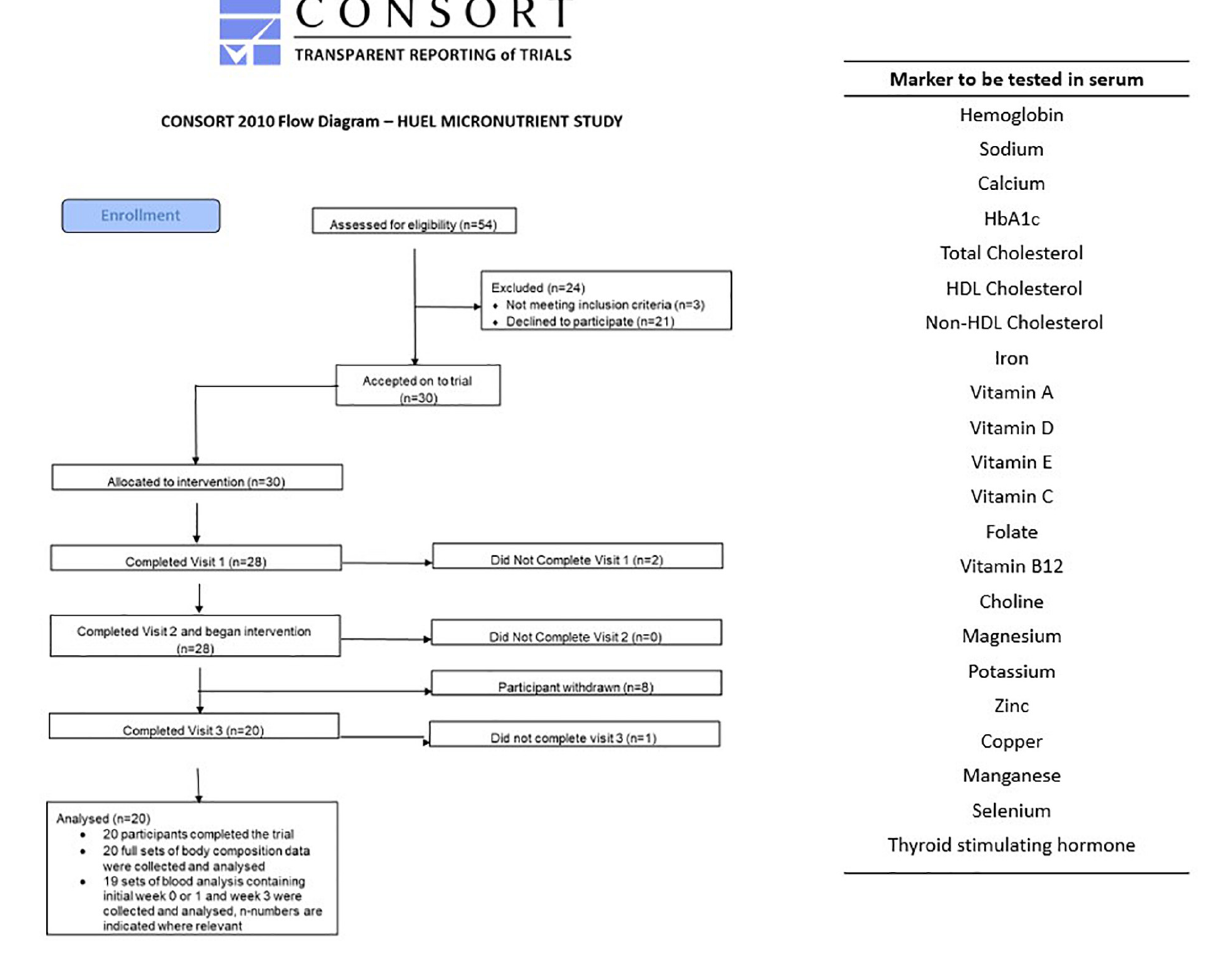
FIGURE 1 | CONSORT diagram and list of blood biomarkers assessed at each of the three visits. The two participants who withdrew at the second visit were due to failed phlebotomy. Of the eight who withdrew before the third visit two gave no reason, two had difficulty maintaining diet, one due to mood changes, one due to stomach issues, and two due to